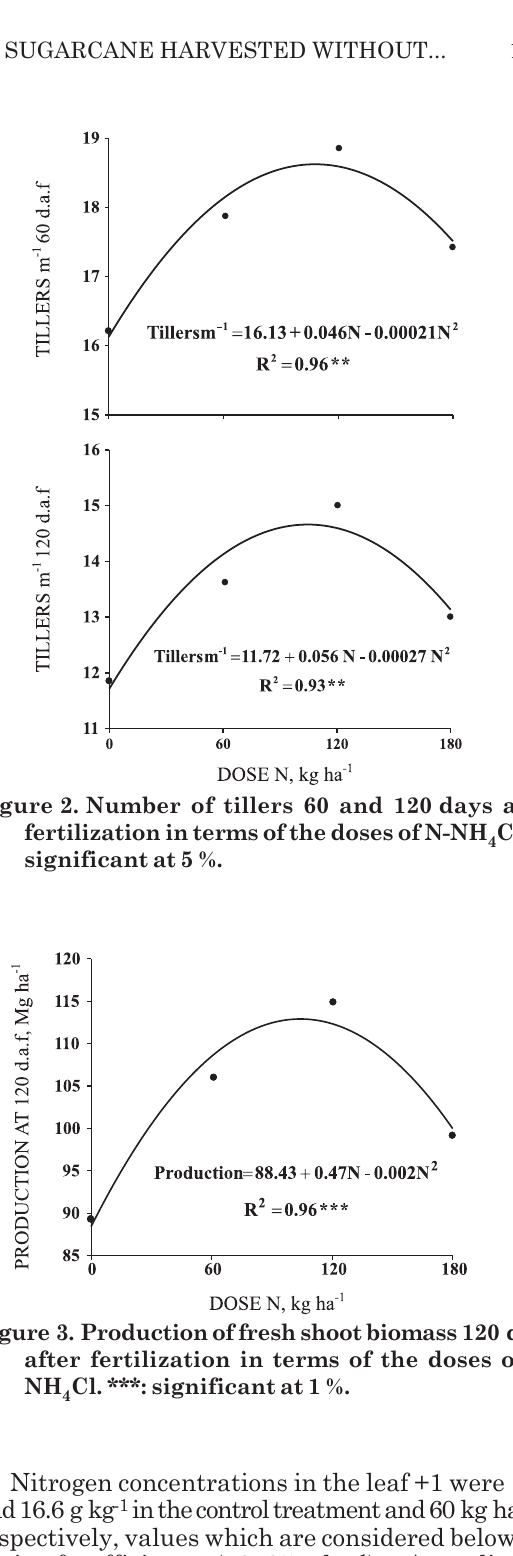
Figure 3. Production of fresh shoot biomass 120 days after fertilization in terms of the doses of N- Cl. ***: significant at 1 NH 4